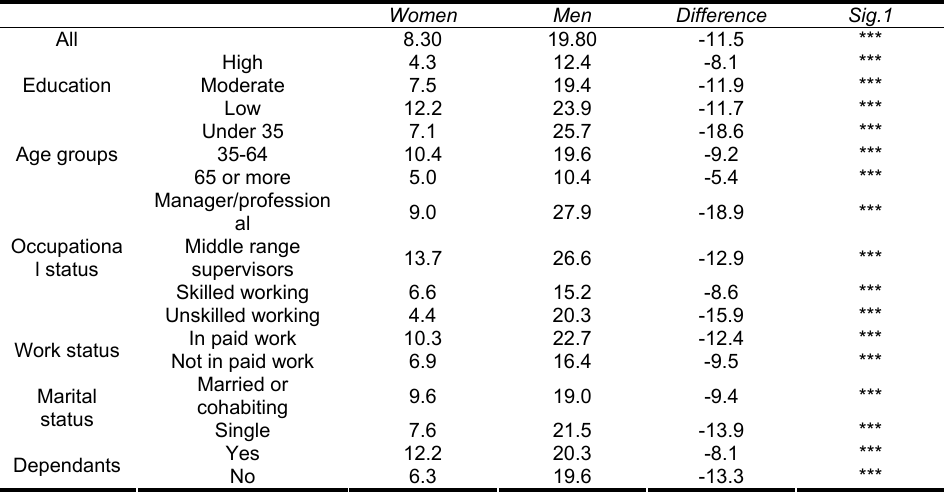
Table 9. Membership percentage of sports organisations according to gender and control